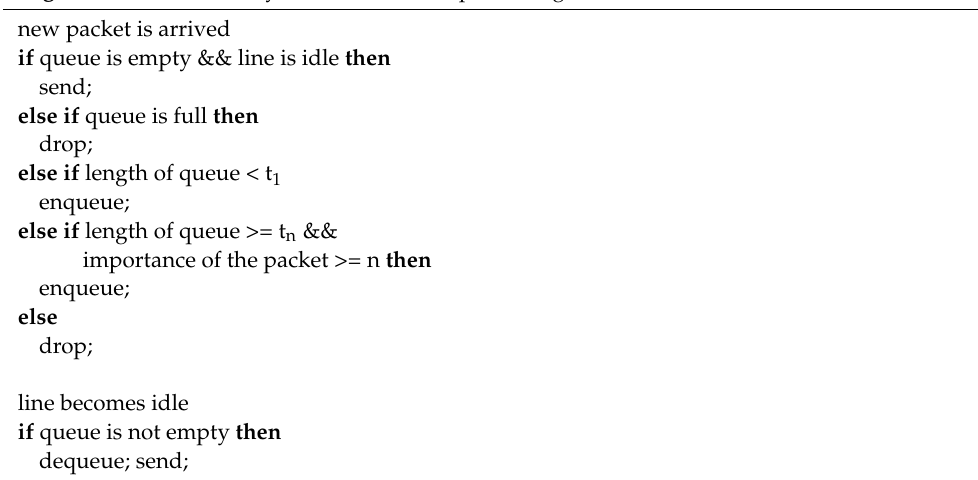
Algorithm 2: Low-latency data service class